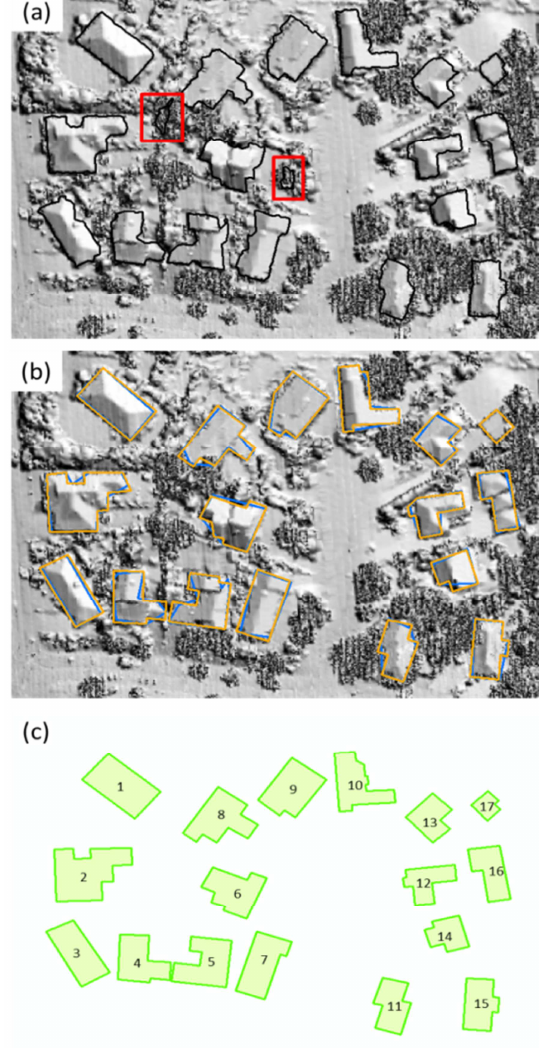
Figure 8. Building footprint reconstruction: (a) the detected buildings, (b) reconstructed footprints and (c) ground